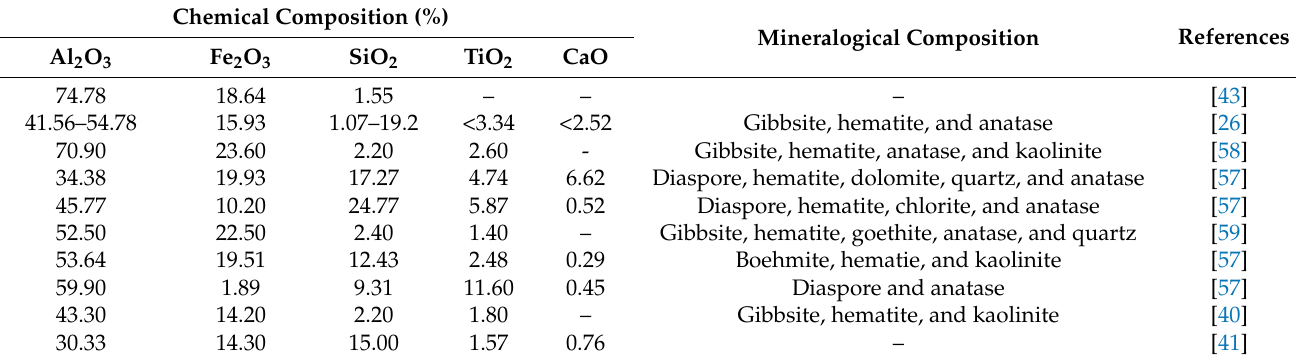
Table 2. Elemental and mineralogical compositions of some bauxite samples used as fluoride adsorbents. Chemical Composition